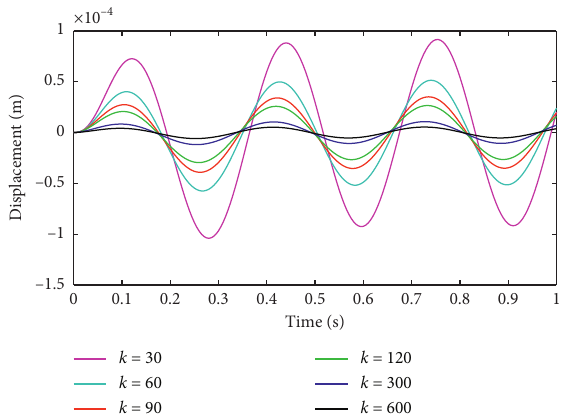
Figure 17: z -axis displacement of the floating